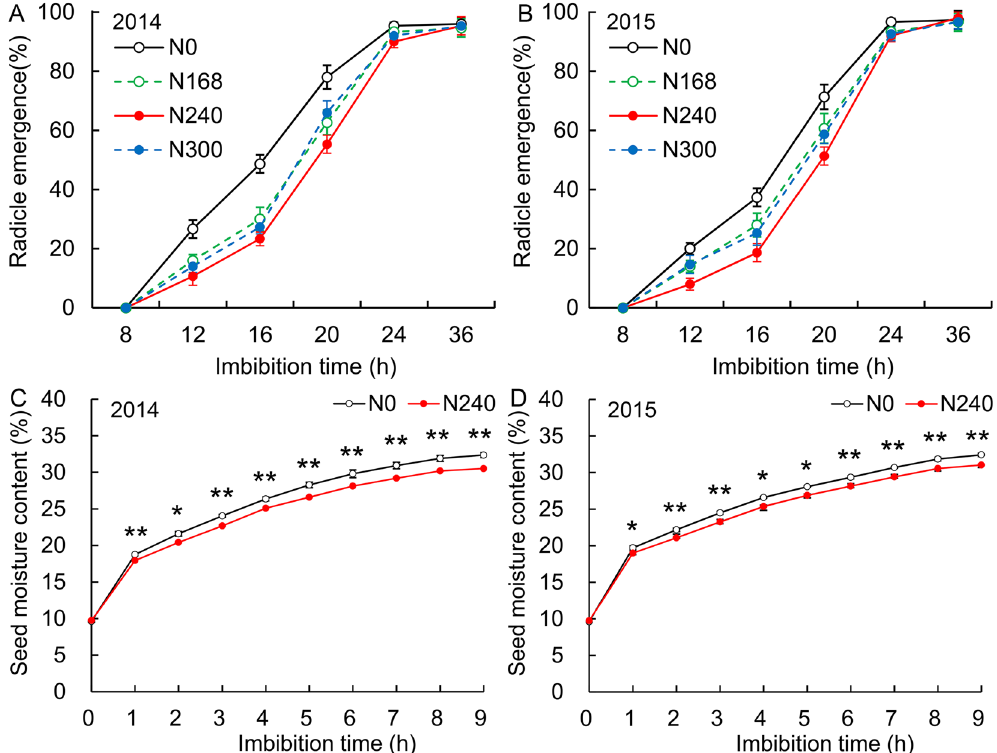
Figure 1. Radicle emergence and seed moisture content under four nitrogen levels. Four nitrogen levels: N0 (0 kg/ha), N168 (168 kg/ha), N240 (240 kg/ha, the usual nitrogen fertilizer level for winter wheat production in the North China Plain) and N300 (300 kg/ha). ( A , B ) Radicle emergence of seeds in 2014 and 2015. ( C , D ) Seed moisture content in 2014 and 2015. Error bars represent the standard deviation for three field plot